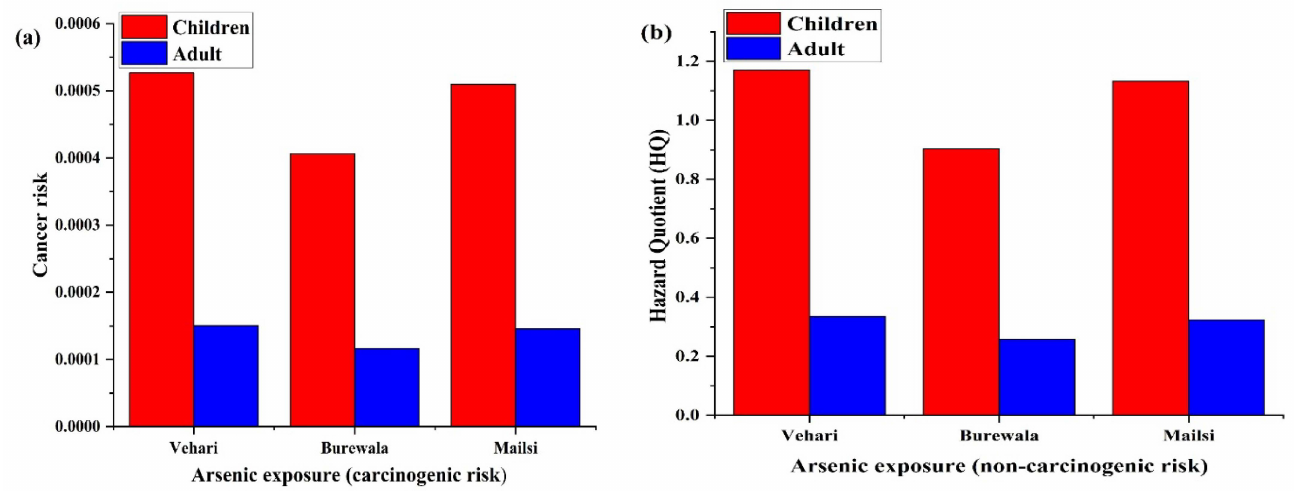
Figure 6. ( a ) Carcinogenic risk (CR) of adults and children. ( b ) Non-carcinogenic risk hazard quotient (HQ) of adults and